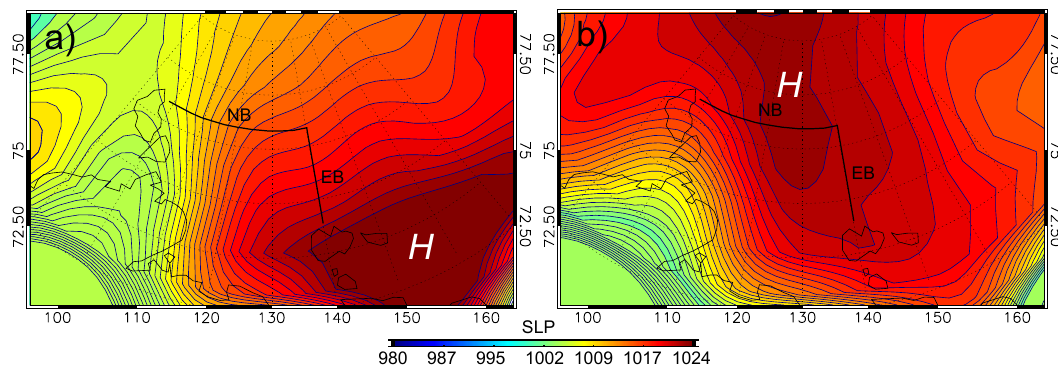
Fig. 8. Sea level pressure fields (mb) for a month of comparatively high (a: March, 2007) and low ice area flux rates (b: April, 1998) and across the northern and eastern boundary. Fig. 9. Origin and drift of sea ice leaving the NB and EB at the end of April as obtained by the back-propagation of ice parcels over a 6-month period (see text for a detailed description). (a) and (b) show ice drift patterns for a winter with high (2008/09) and low (1998/99) ice transportation rates across boundaries. The color represents the position of the sea ice at a specific month before exiting the northern or eastern boundary. The trajectory of sea ice leaving the Laptev Sea through the center of the NB and EB are represented by black lines. (c) shows the frequency of origins (position in November) of sea ice between 1992 and 2011.